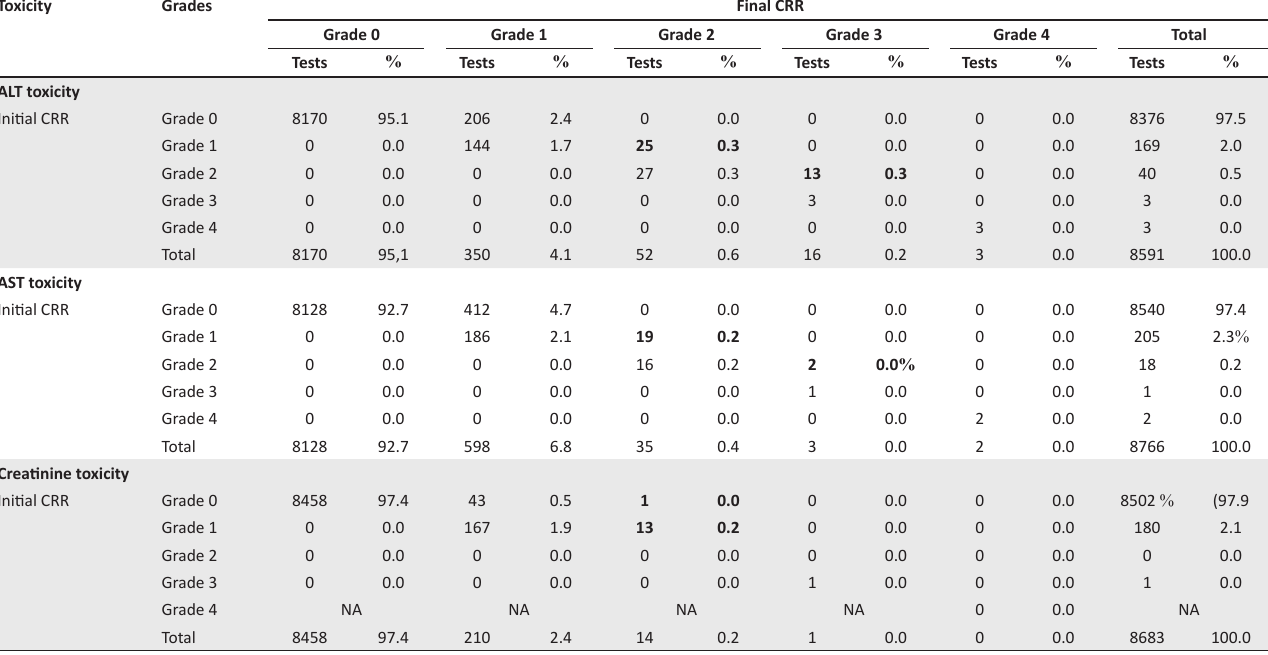
TABLE 4: Toxicity grades for AST/ALT and creatinine using initial versus final reference ranges. Toxicity Grades